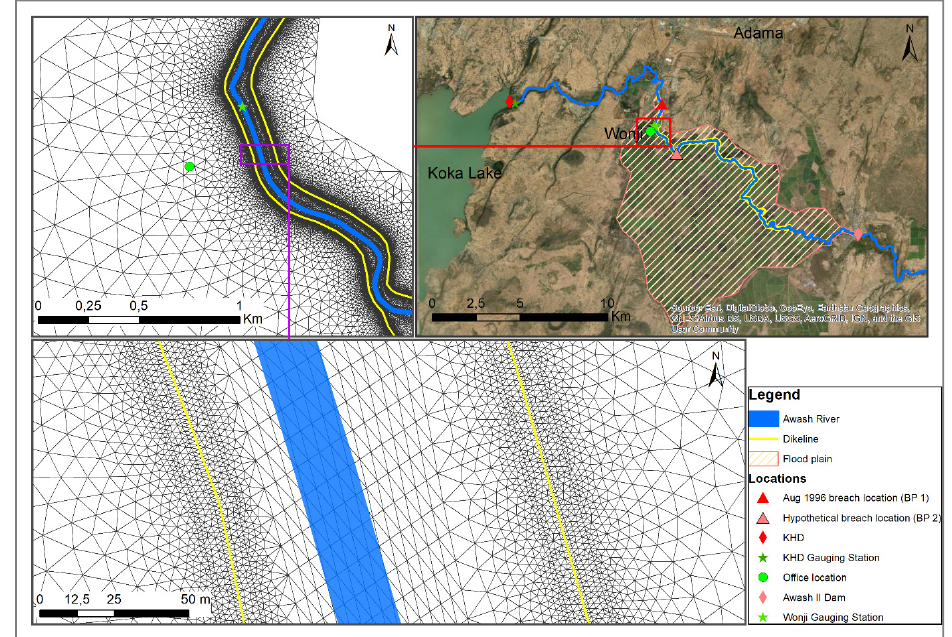
Figure 4. Excerpt of the computational mesh.